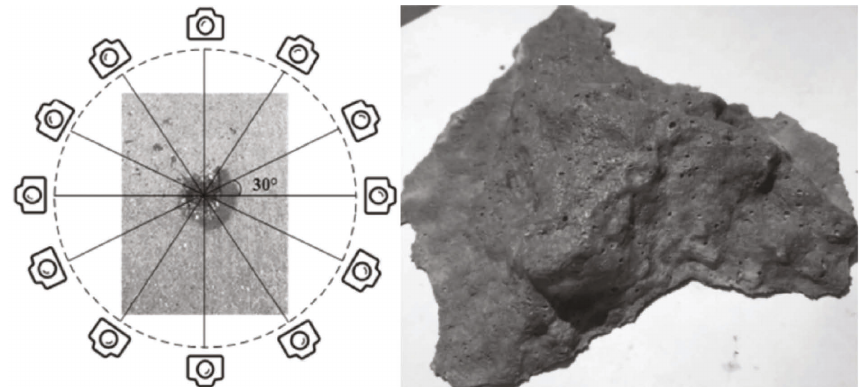
Figure 32: Photographing of pavement damage and concrete patch [64].